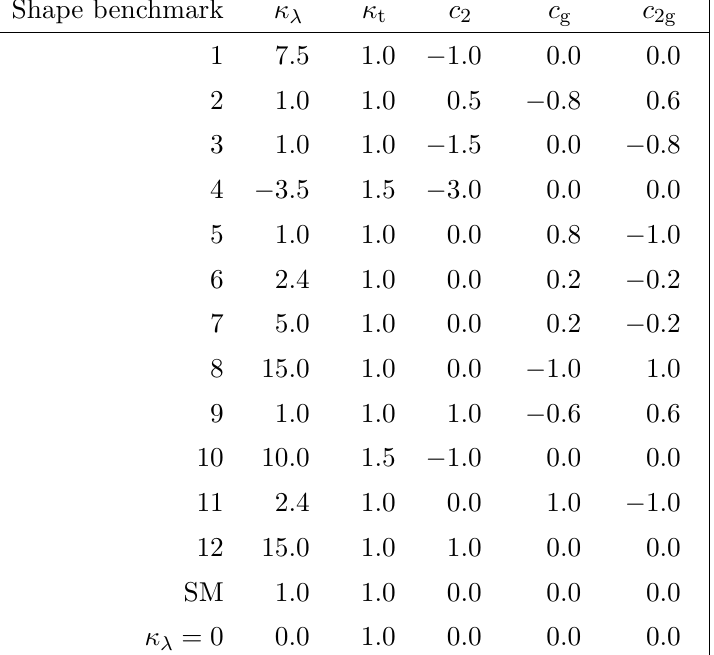
Non-resonant HH signals were generated using the e(cid:11)ective (cid:12)eld theory approach